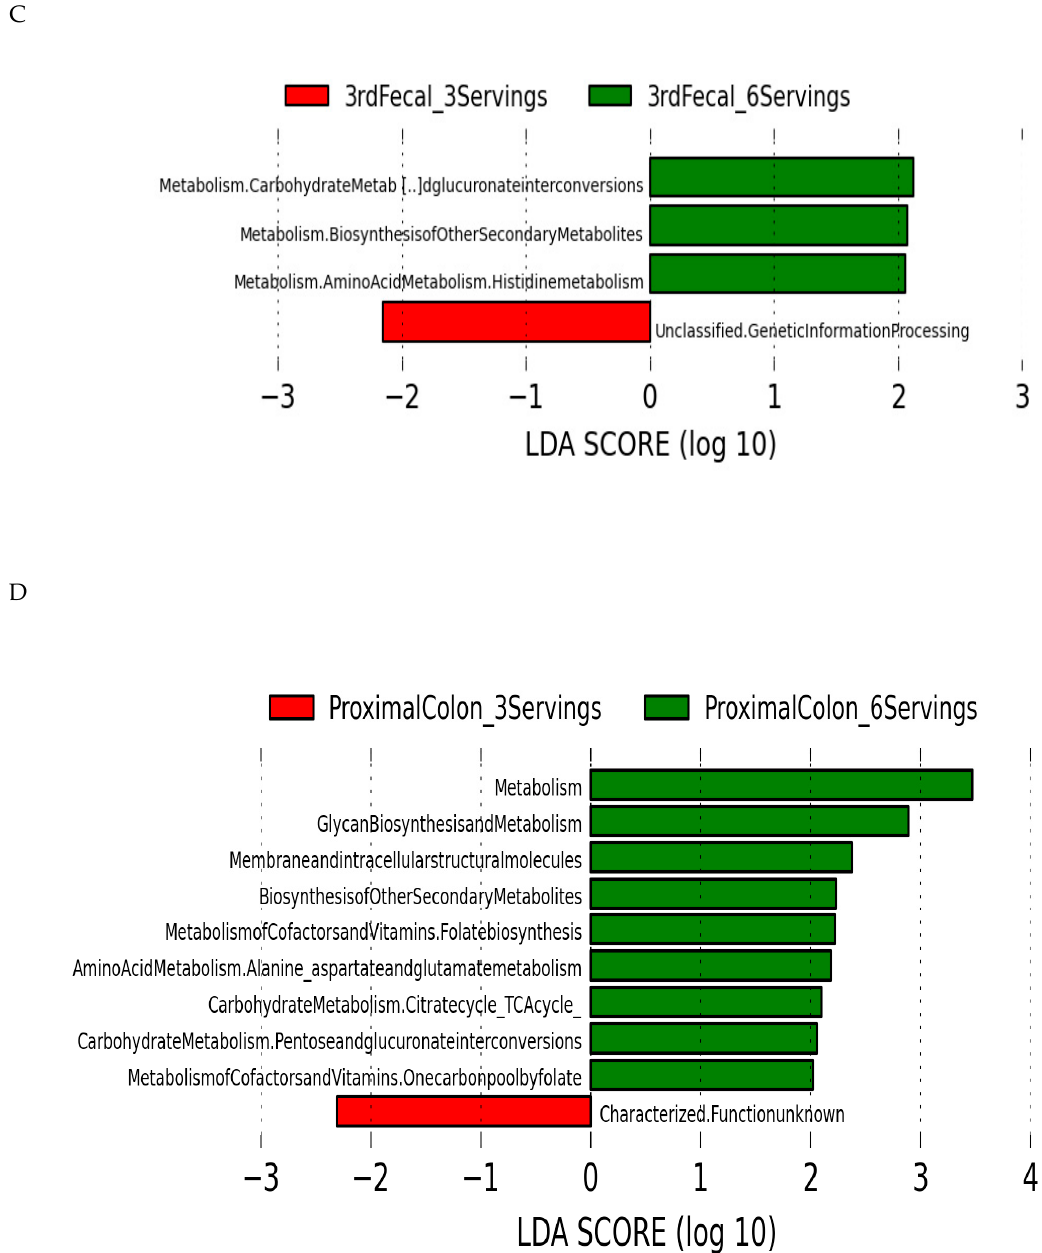
Figure 4. Phylogenetic Investigation of Communities by Reconstruction of Unobserved States. (PICRUSt) analysis of predicted functional pathways in the pig fecal and colonic microbiota. Imputed metabolic function results in the gut fecal microbiota of pigs fed three servings of WB mushrooms vs. control ( A ), six servings of WB mushrooms vs. control ( B ), three servings vs. six servings ( C ) and colonic microbiota from pigs fed three and six servings of WB mushrooms ( D ). Only taxa with linear discriminant analysis scores > 2 are presented. Each color in the pie chart represents the corresponding bacterial taxa in the legend.